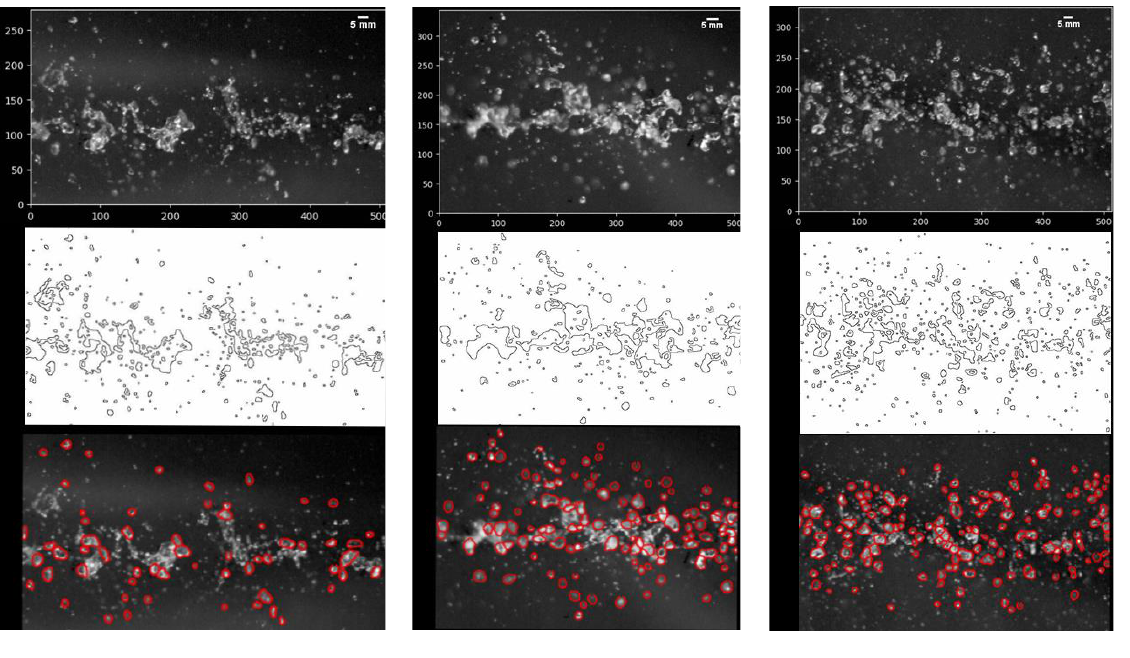
Figure 4. The original picture, contour, and outline of droplets sprayed from nozzles with different orifice shapes under 200 kPa. (Circular nozzle, square nozzle, and triangular nozzle, from left to right).